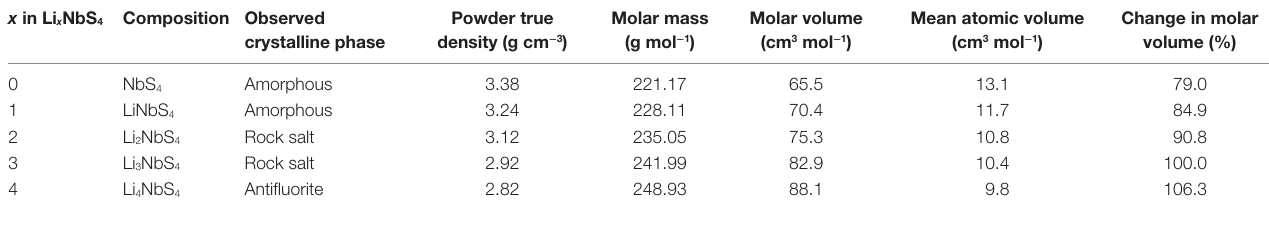
TaBle 1 | Powder true density, molar mass, molar volume, mean atomic volume, and change in molar volume (vs. li 3 nbs 4 ) of lithium niobium sulfides (li x nbs 4 ) prepared by